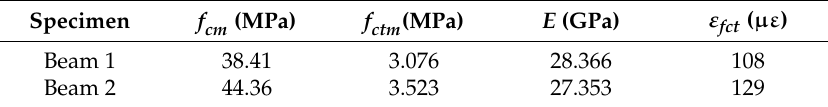
Table 1. Mechanical properties of the